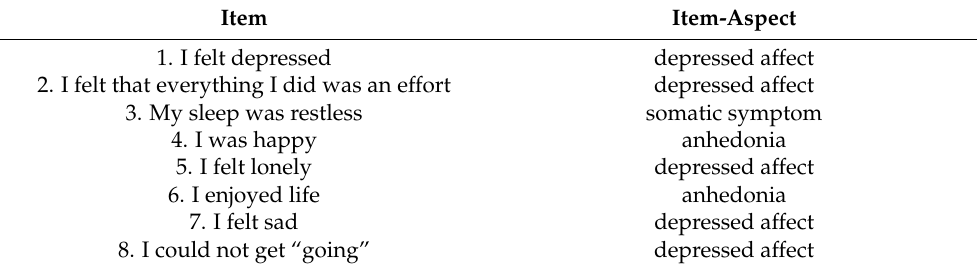
Table 1. The 8-item Scale Driven from the CES-D to Screen Individuals’ Depressive Traits. Item